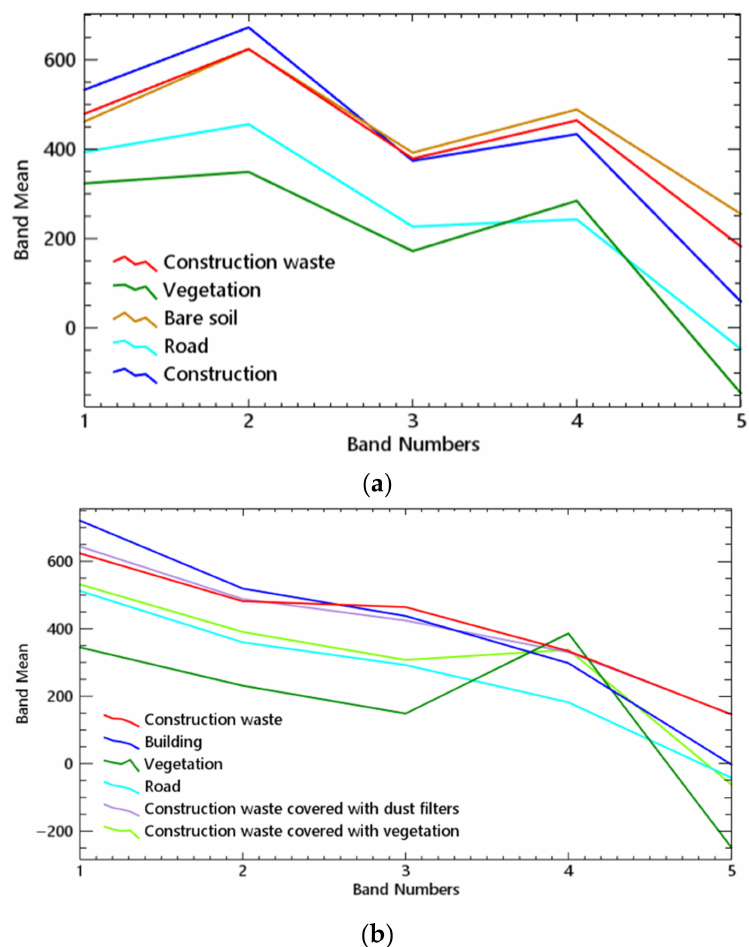
Figure 3. Spectral distribution of cases A and B: ( a ) Case A; ( b ) Case